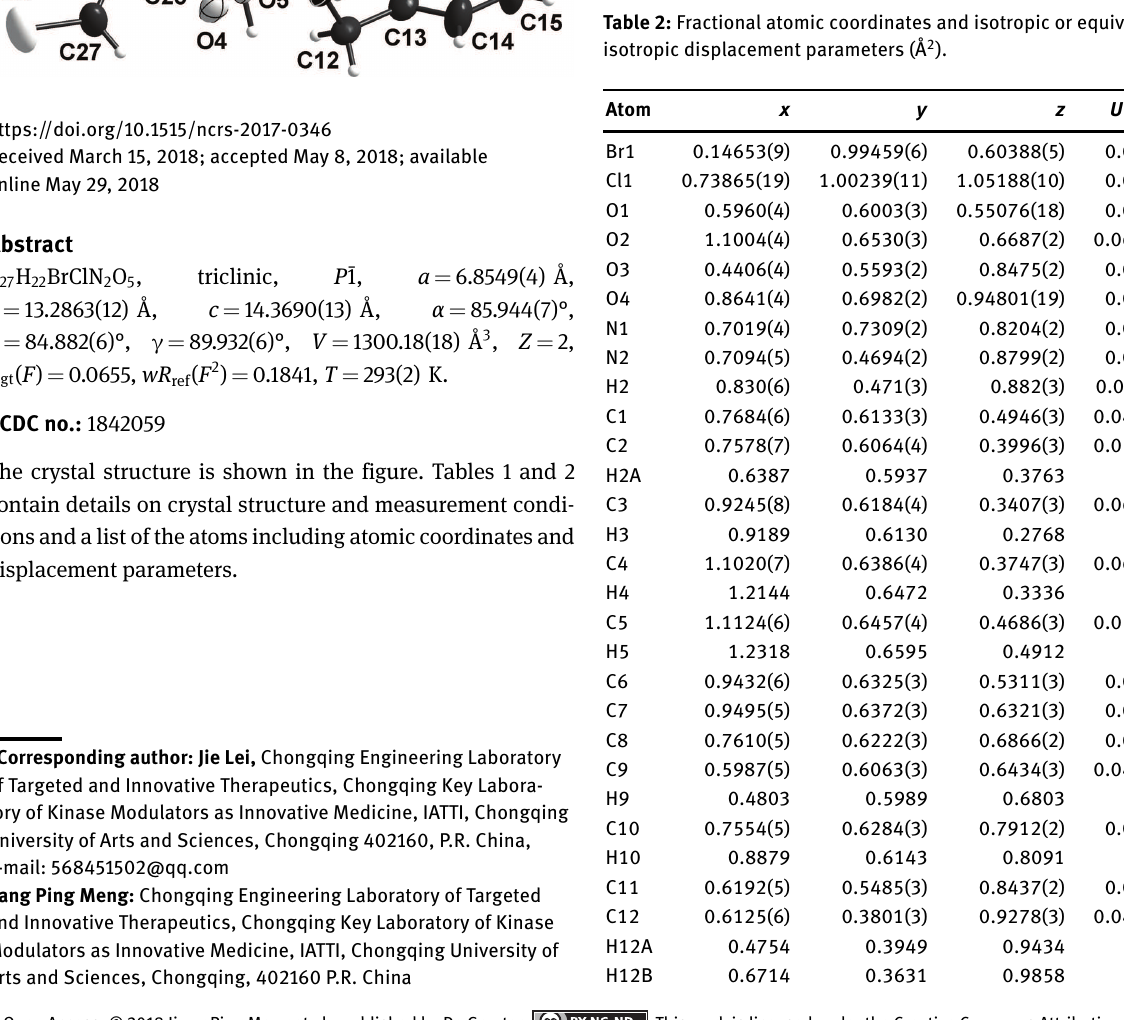
Table 2: Fractional atomic coordinates and isotropic or equivalent isotropic displacement parameters (Å 2